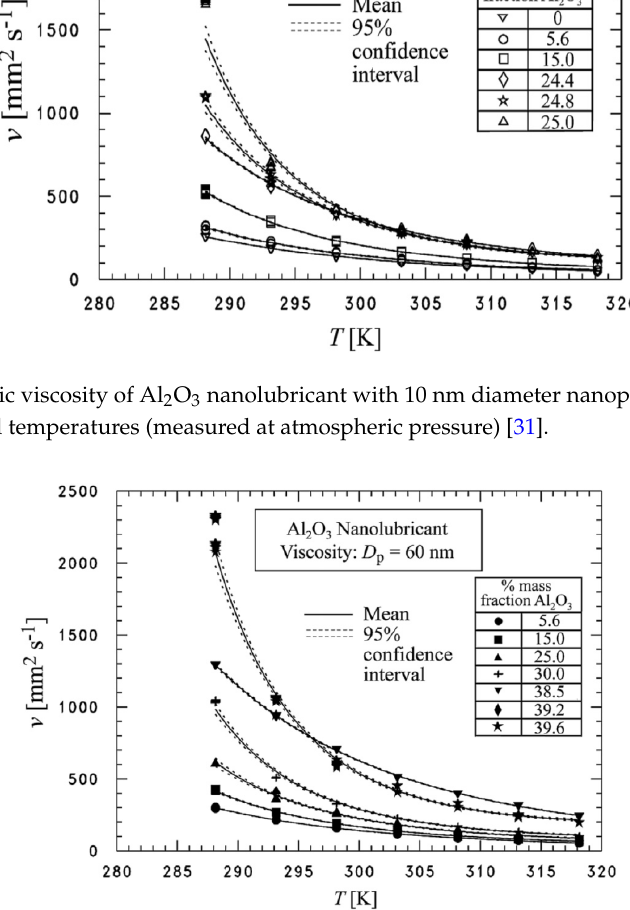
Figure 8. Kinematic viscosity of Al 2 O 3 nanolubricant with 60 nm diameter nanoparticles for various mass fractions and temperatures (measured at atmospheric pressure) [31].